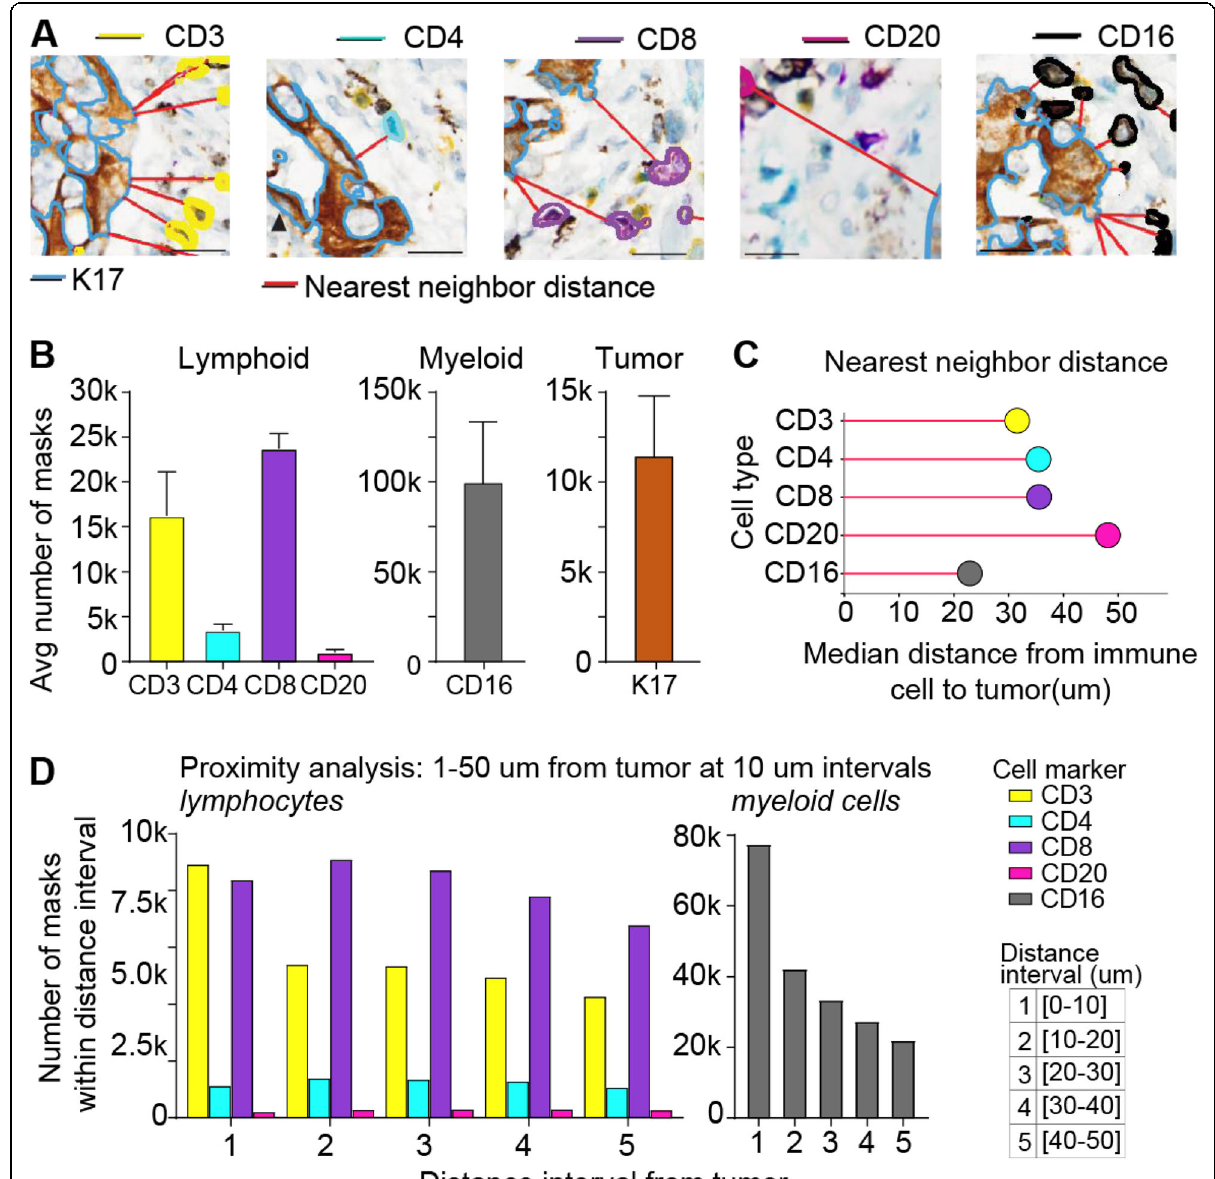
Fig. 6 Example of analyses describing immune-tumor spatial relationships in mIHC-stained PDAC tissue. A . Representative images of segmentation boundaries of detected tumor nests and immune cells labelled with IHC biomarkers: K17 (blue segmentation boundary), CD3 (yellow boundary), CD4 (teal boundary), CD8 (purple boundary), CD20 (magenta boundary), and CD16 (black boundary). Red lines indicate nearest neighbor distance vector connecting each immune cell to the nearest tumor nest. B . Average number of masks per case for each of the different cell classes in three WSIs. C . Median nearest neighbor distances for each immune cell class across cases. D . Proximity analysis showing the number of detected masks for each cell class at 10 um distance intervals from the tumor boundary. *Note: Nearest Neighbor analyses are asymmetric and Nearest Neighbor analyses from each tumor nest to nearest immune cell are shown in supplemental Fig.